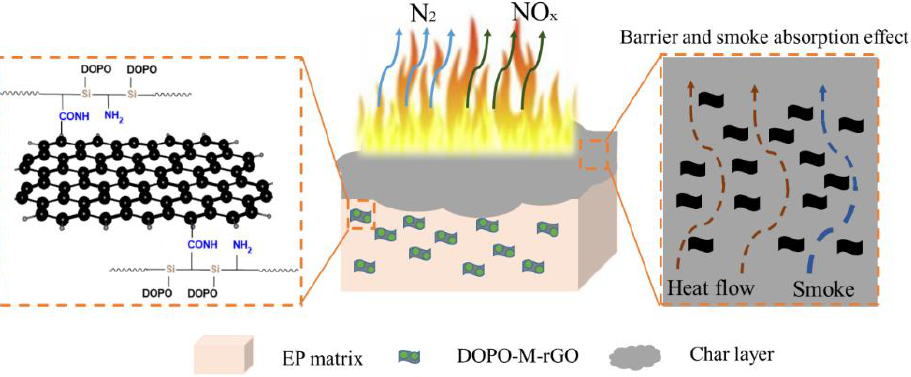
Figure 10. Schematic illustration of flame -retardant mechanism of DOPO-M-rGO in EP.